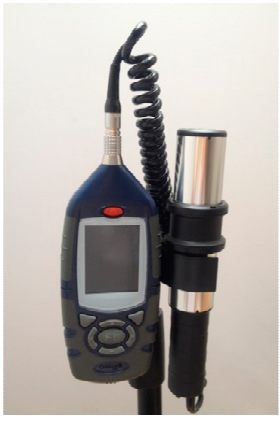
Figure 6. Casella measuring device.